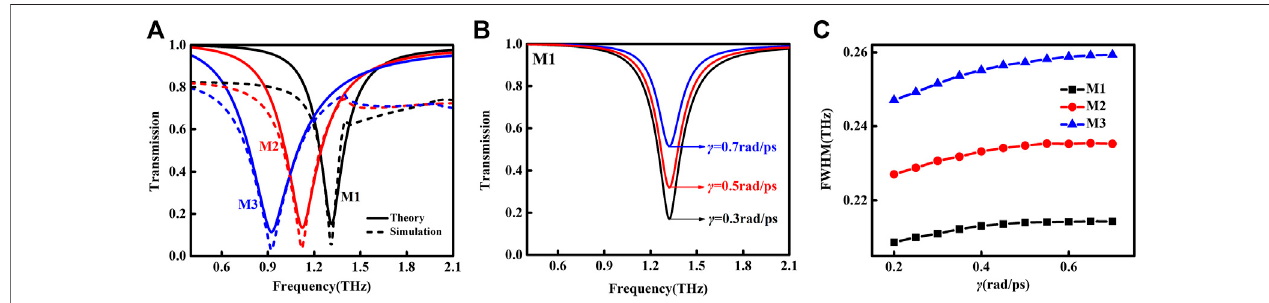
FIGURE 2 | (A) Theoretical (solid line) and simulated (dashed line) transmission spectra of M1, M2, and M3, respectively. (B) The line shape of resonant transmission of M1 under different γ . (C) Dependency between FWHM and γ for M1, M2, and M3,